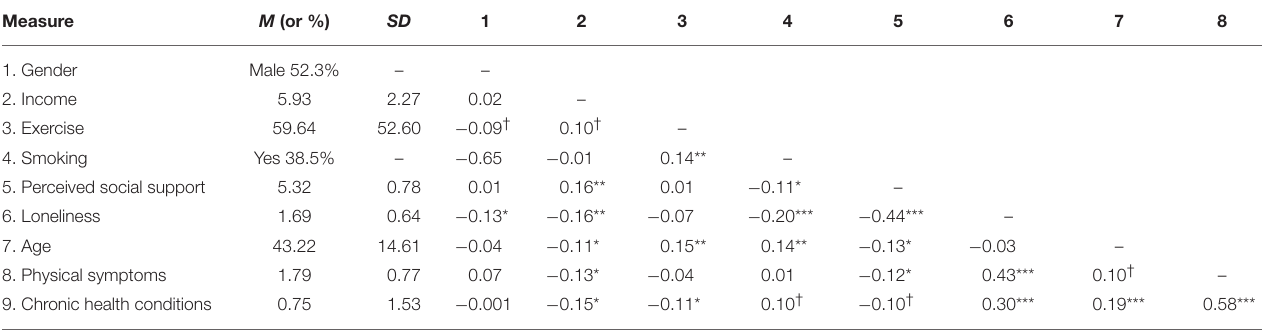
TABLE 1 | Descriptive statistics and correlations among measures in Study 1. Measure